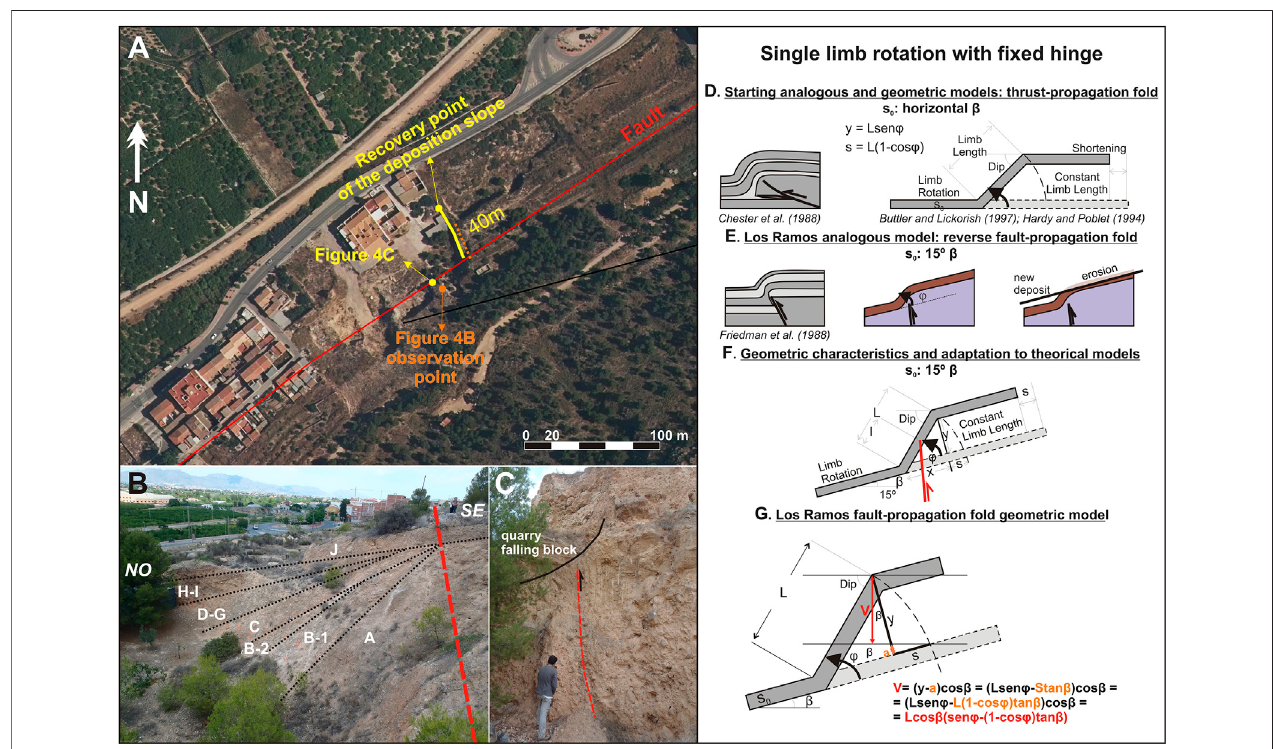
FIGURE4|(A) AerialphotographoftheLosRamosquarry.Locationofthestudiedoutcropandthefault. (B) Photographofthestudiedoutcropwiththeschemeof the progressive discordance. (C) Photograph of the fault on the SE wall. (D) Graphic representation of the analogous and geometric models for detachment and thrust- propagation folds( β :depositionaldip;y:vertical slip;s:horizontal shortening;L: limblength; φ :rotationangle). (E) Analogousmodelforinversefault-propagationfoldsto which the progressive discordance adjusts and diagram of formation. (F) Geometrical characteristics of the Los Ramos propagation fold and its adaptation to the theoretical geometrical models (l: length of the synclinal part of the limb; x: horizontal slip). (G) Geometrical model of the Los Ramos propagation fold (V: vertical component of the net slip of the fault; a: vertical component of the depositional dip).